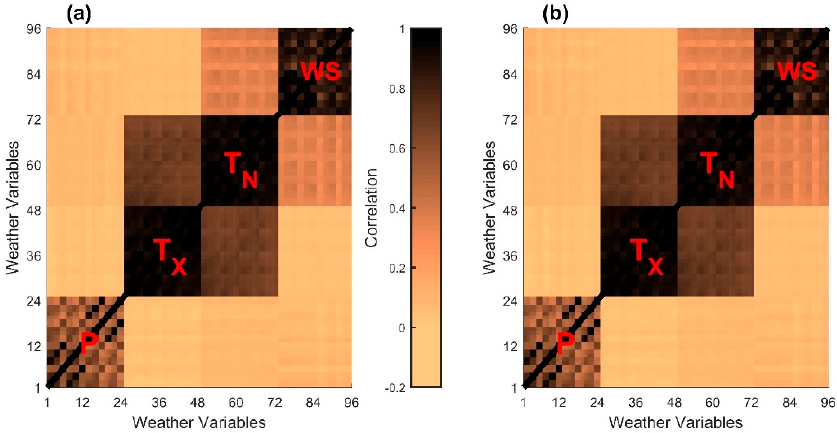
Figure 8. Spatial and cross correlation coefficients of the daily observed ( a ) and simulated variables ( b ).